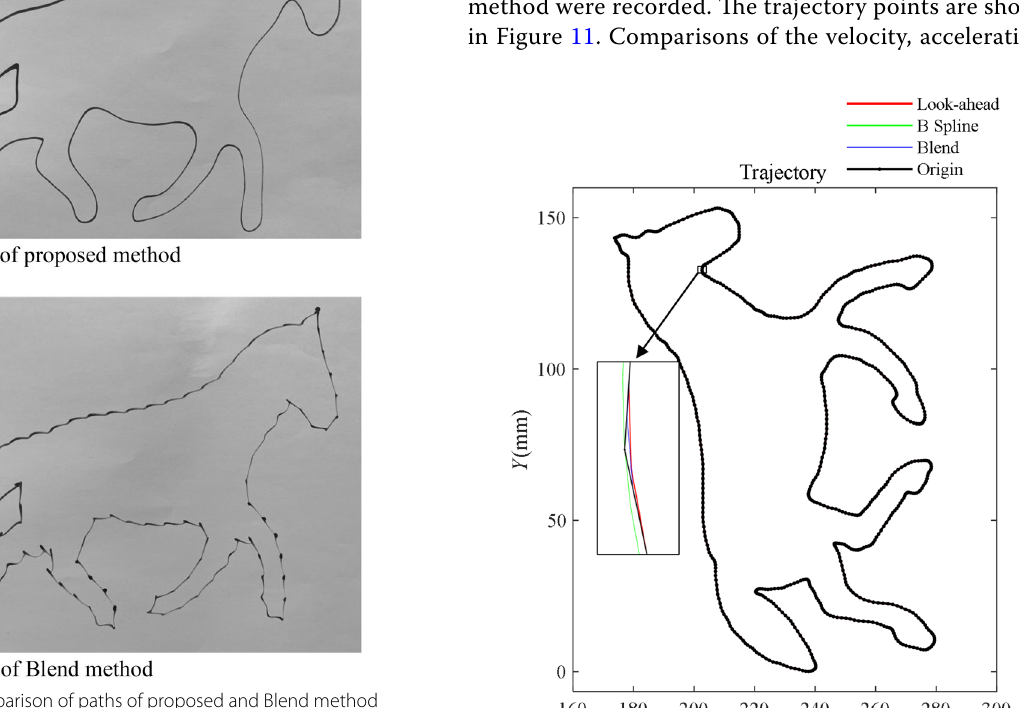
The running time of the Blend method and B spline method are equal to that of the proposed method. Dur- ing the period when the robot drew the picture of a horse, the trajectory points, velocity, and acceleration of the proposed method, B spline method and Blend method were recorded. The trajectory points are shown in Figure 11. Comparisons of the velocity, acceleration,